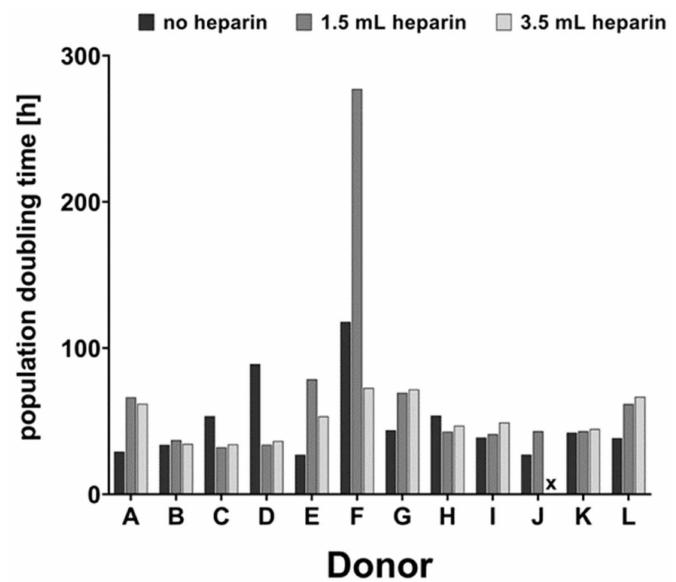
Figure 3. Population doubling times. Determined for individual cell preparations between passage 1 and 2. x: cells stopped to proliferate.